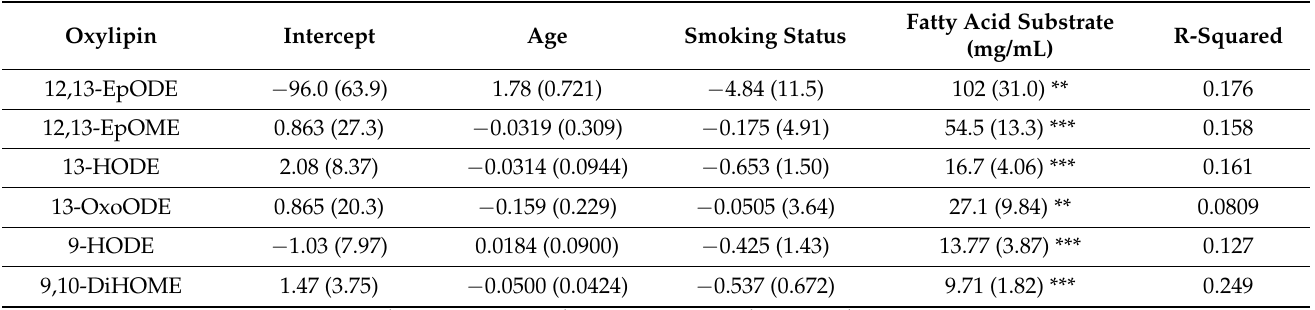
Table 2. Statistically Significant Regression Models Predicting Plasma Oxylipin Concentrations in Patients Living with PAD [Estimate (Standard Error of the